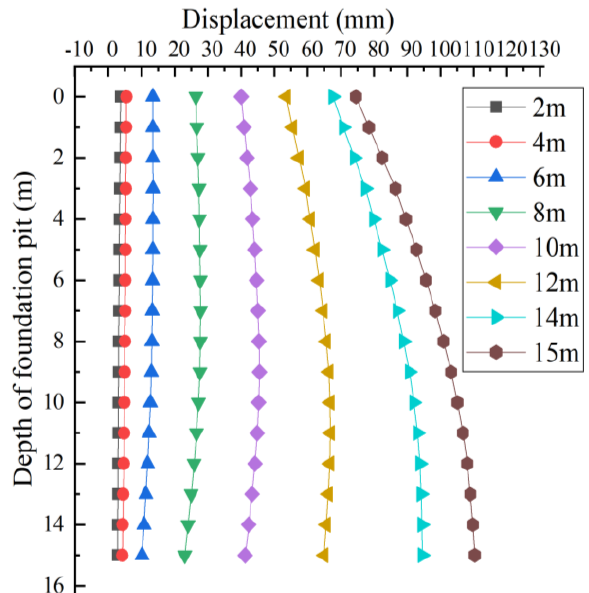
Figure 20. Pile displacement